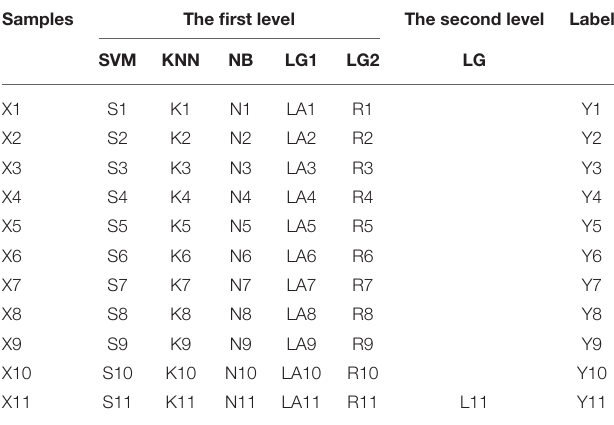
TABLE 2 | Example of stack integration.